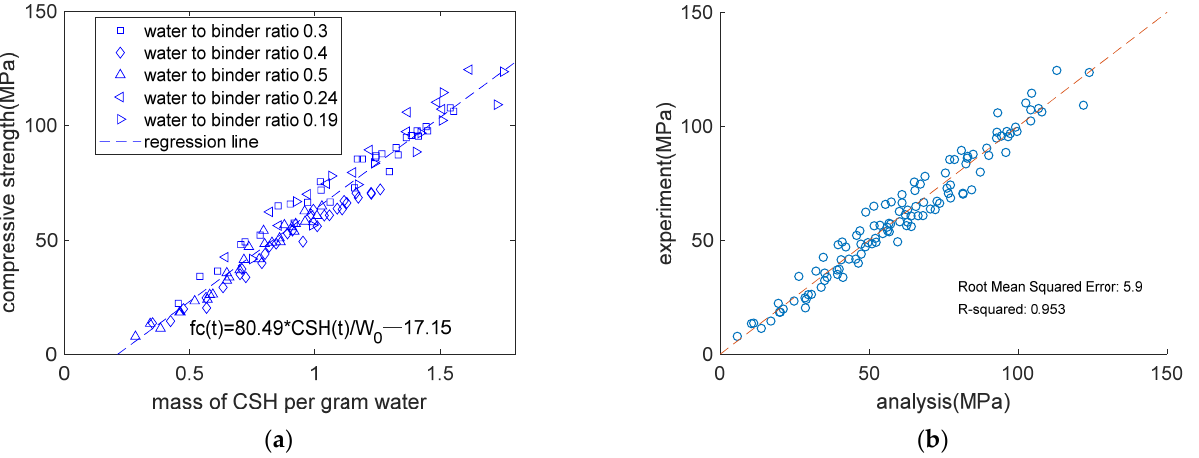
Figure 3. Verification of strength model. ( a ) Strength versus CSH. ( b ) Experimental versus analytical strength results.